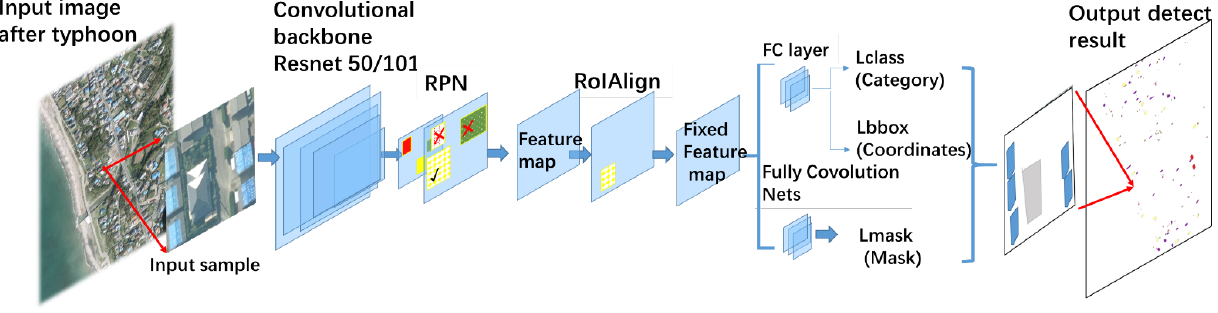
Figure 6. Framework of the deep